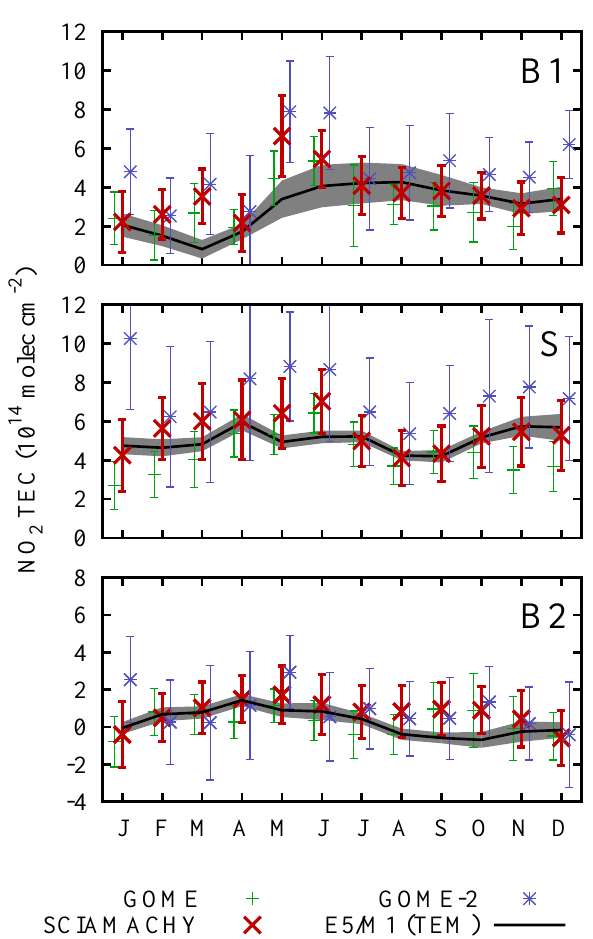
Fig. 4. Monthly mean NO 2 tropospheric column in three selected regions over the Indian Ocean. Satellite data from SCIAMACHY, GOME and GOME-2 are denoted by symbols. For model output columns are derived by tropospheric excess method (TEM). The shaded area for the model simulations shows the interannual stan- dard